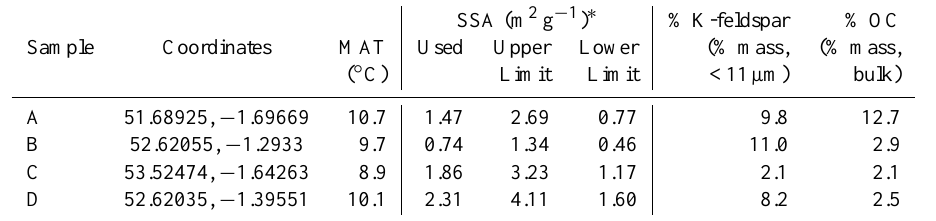
Table 1. Soil sample information. Location, mean annual (air) temperature (MAT), specific surface area as estimated by laser diffraction (SSA), K-feldspar content in the dust fraction and bulk organic carbon content of the soils examined during this study. Mean annual air temperatures are calculated from 5km × 5km grid cells of UK Climate Projections (UKCP09) observation data sets provided by the UK Met Office.